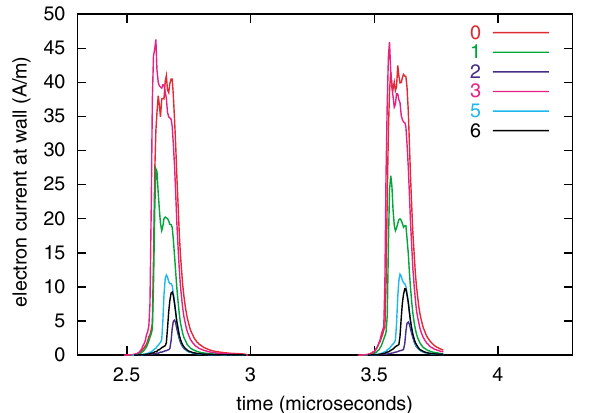
FIG. 9. (Color) SNS electron current into the wall for the simulations shown in Fig. 8. The charge deposited ranges from 40 to 700 pC = cm 2 = turn